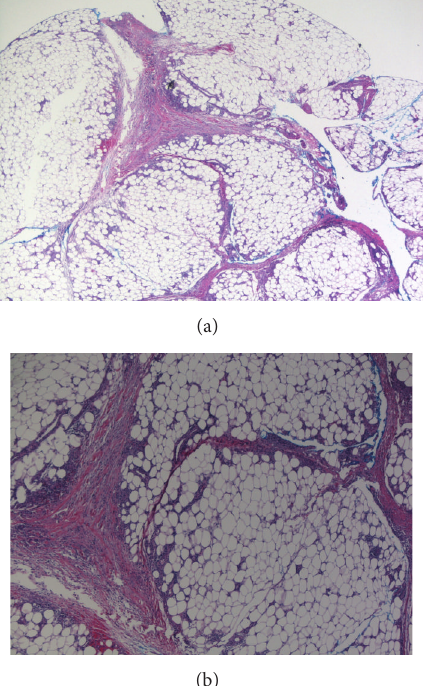
Figure 2: (a) Low-power and (b) medium-power histopathology revealing septal panniculitis and inflammation with septal edema and fibrosis (hematoxylin-eosin stain, 20x and 40x original magni- fication,